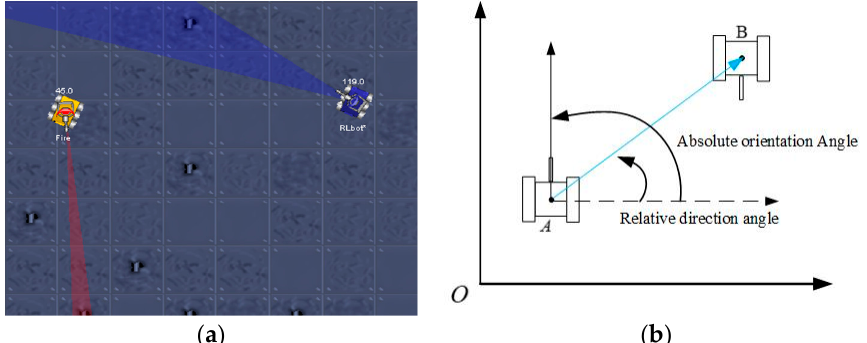
Figure 7. Robot confrontation platform. ( a ) a platform for the tank battle system, ( b ) diagram of absolute and relative angles.